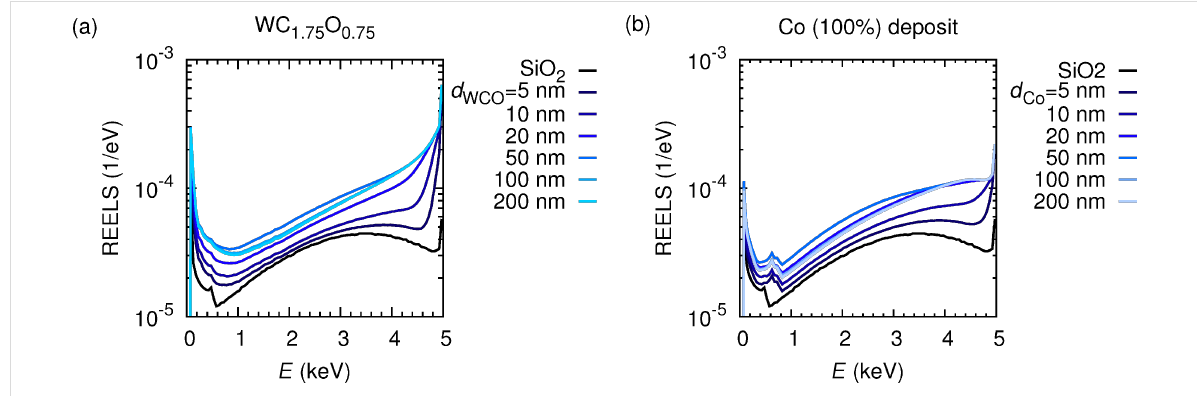
Figure 5: (a) Distribution of electrons backscattered and emitted into the vacuum from the substrate in absence of a deposit (black curve) and from the substrate with a deposit of thickness d WCO in the range from 5 to 200 nm (blue curves), which consists of the material corresponding to the com- position WC 1.75 O 0.75 (see Table 1). (b) Same as panel (a) for a deposit of pure Co. Notice that the ordinates are in a logarithmic scale, whereas the abscissas are in a linear scale. The acronym REELS stands for reflection electron-energy-loss